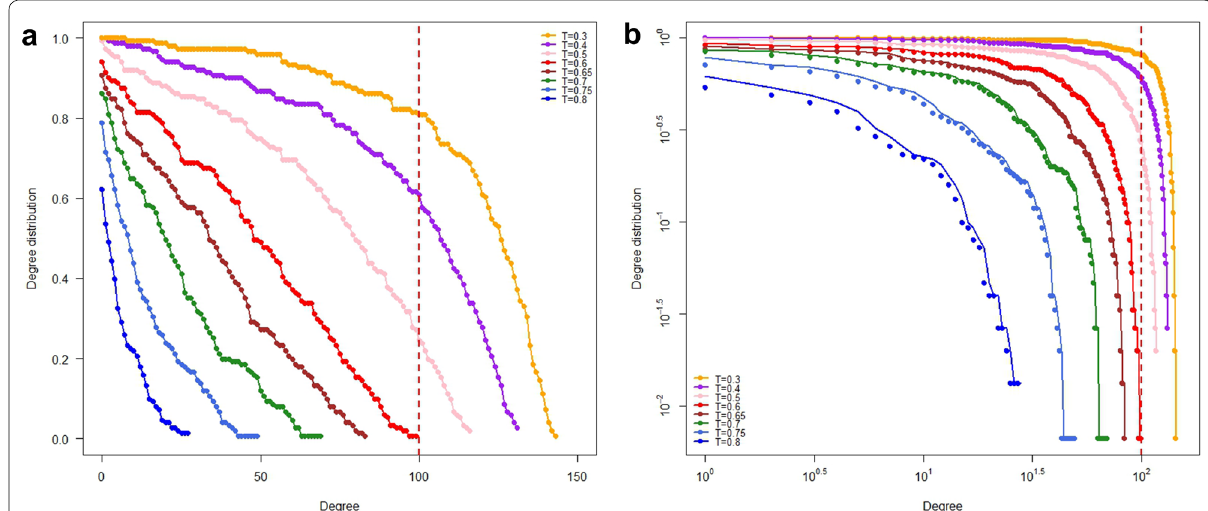
Fig. 8 Degree distribution for the annual streamflow network from the Mississippi River basin for eight different thresholds ( T ) (0.3, 0.4, 0.5, 0.6, 0.65, 0.7, 0.75, and 0.8): a normal scale; and b log–log